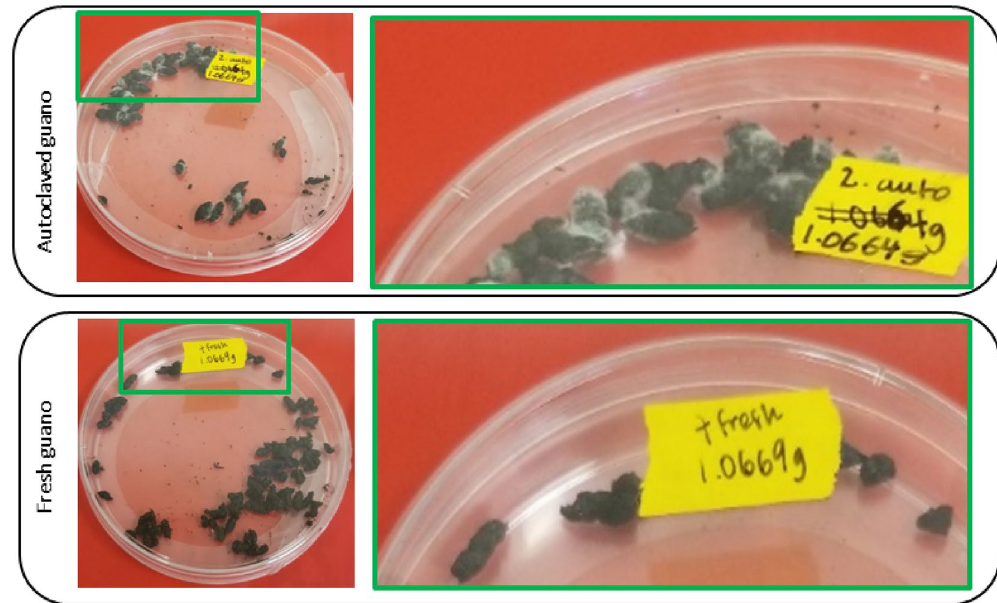
Figure 3. Plates of autoclaved guano and fresh guano pellets 48 days after inoculation. Top row shows visible growth of Pseudogymnoascus destructans on autoclaved guano pellets compared to bottom row without visible growth on fresh guano pellets.